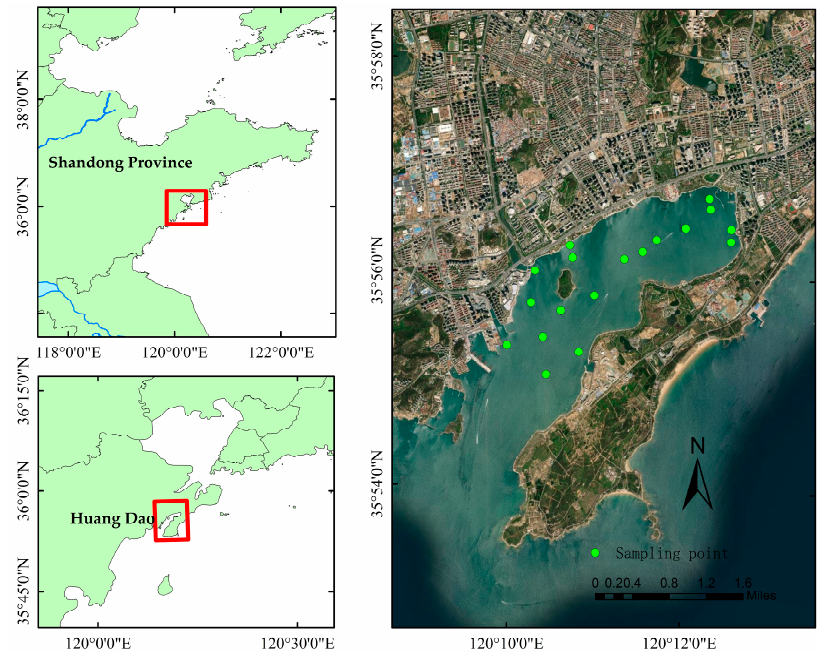
Figure 5. The maps of Tangdao